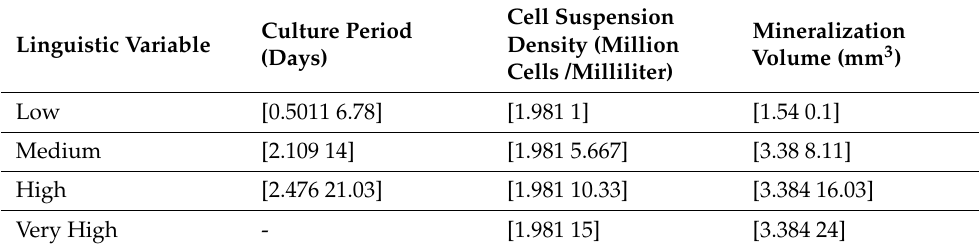
Figure 3. Type-1 and Type-2 Fuzzy Membership Functions. ( a – c ) Type-1 MFs for the two inputs, ( a ) culture period and ( b ) cell suspension density, as well as the single output ( c ) mineralization volume. ( d – f ) Type-2 MFs for ( d ) culture period, ( e ) cell suspension density, and ( f ) mineralization volume. Type-2 membership functions are designed with 0.2 lag. Upper (red) and lower (blue) boundaries are as illustrated. Table 2. Gaussian membership functions range [Sigma,